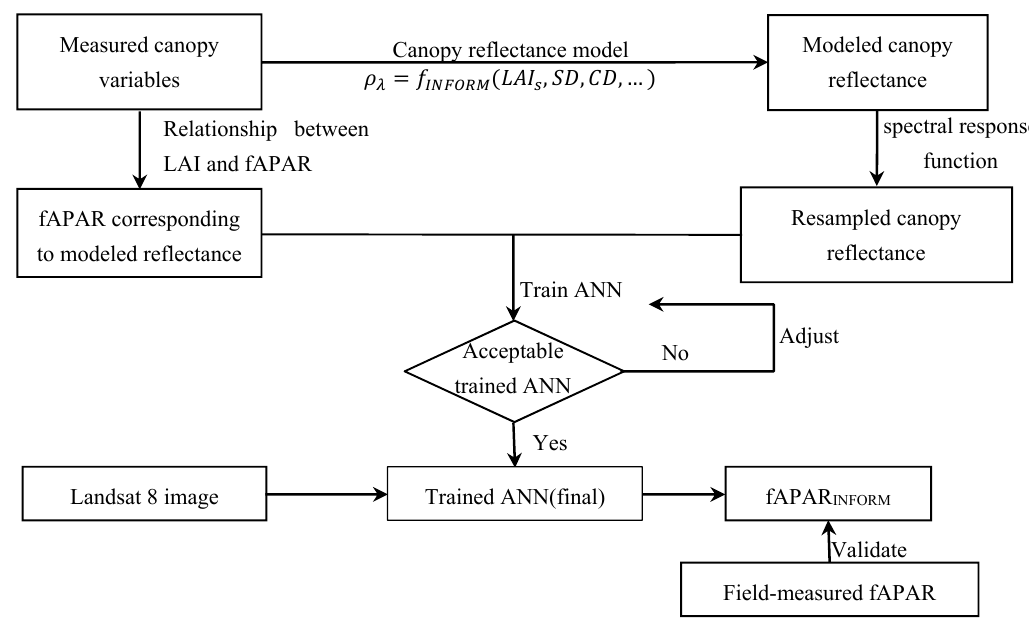
Figure 6. General procedure for estimating forest fAPAR from Landsat data using a forest reflectance